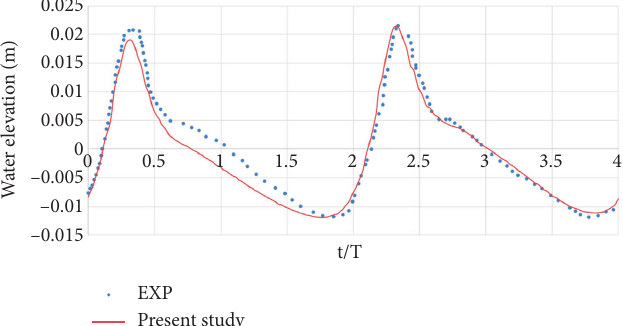
Figure 6: Water surface elevation at x � 12 . 5.